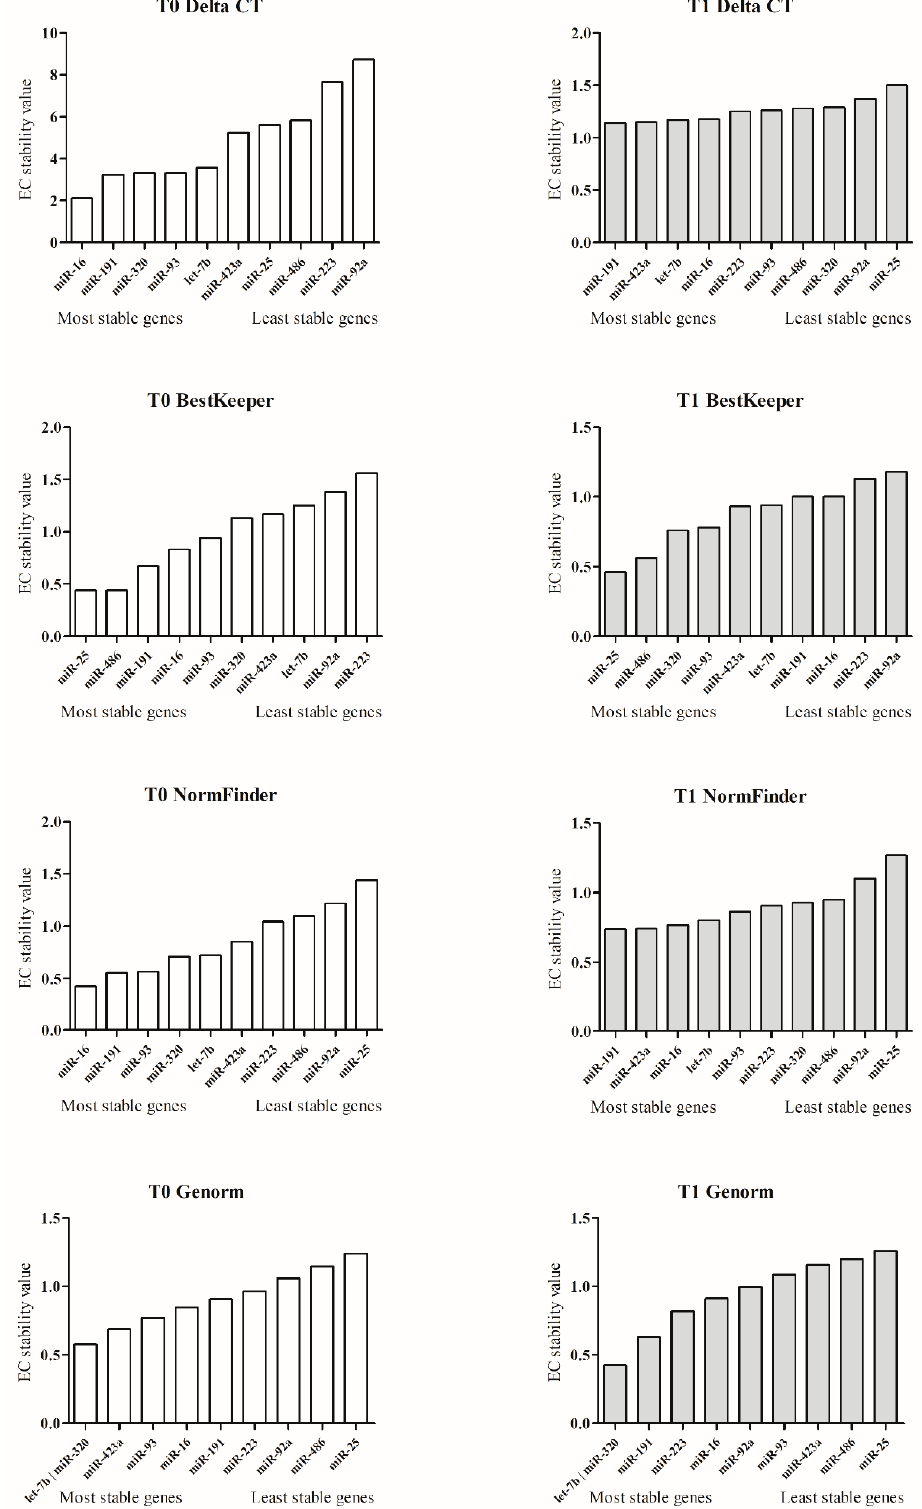
Figure 2. MiRNA stability value. The figure shows the EC miRNA stability value resulting from the Delta-Ct, BestKeeper, NormFinder, and GeNorm mathematical approaches. The left column plots (white) show the stability of miRNAs evaluated at T0, and the right column plots (grey) the miRNA stability assessed at T1. The miRNAs on the x -axis, near the origin, are the most stable; conversely, the miRNAs that are distant are the least stable.